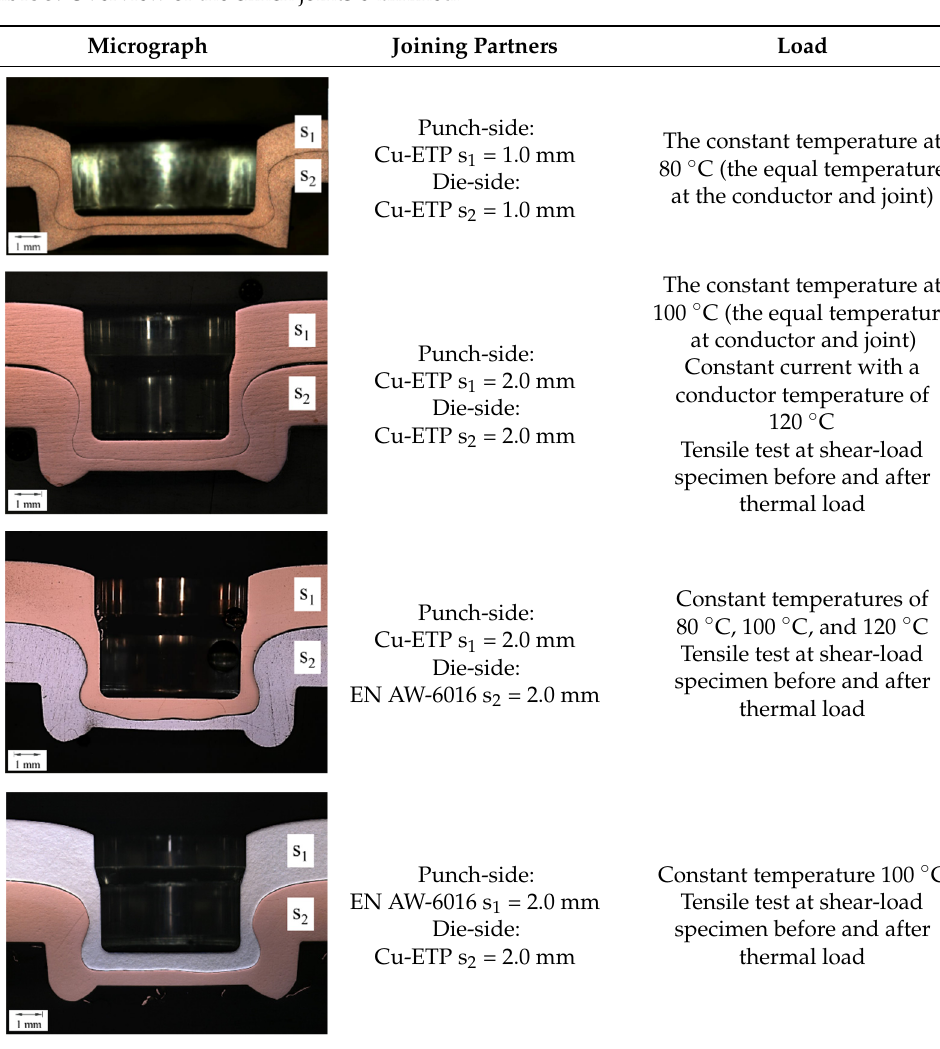
Table 3. Overview of the clinch joints examined.